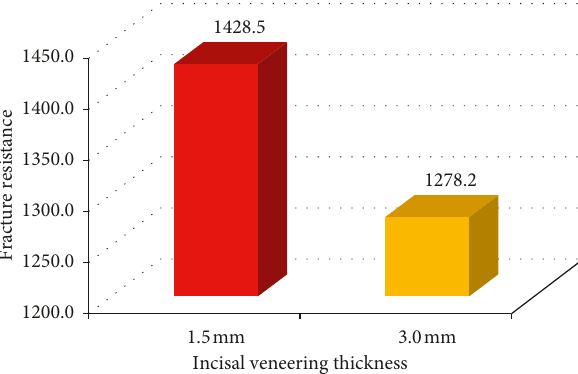
Figure 14: Bar chart showing fracture resistance of the two incisal veneering thicknesses in CAD/CAM zirconia all-ceramic groups.